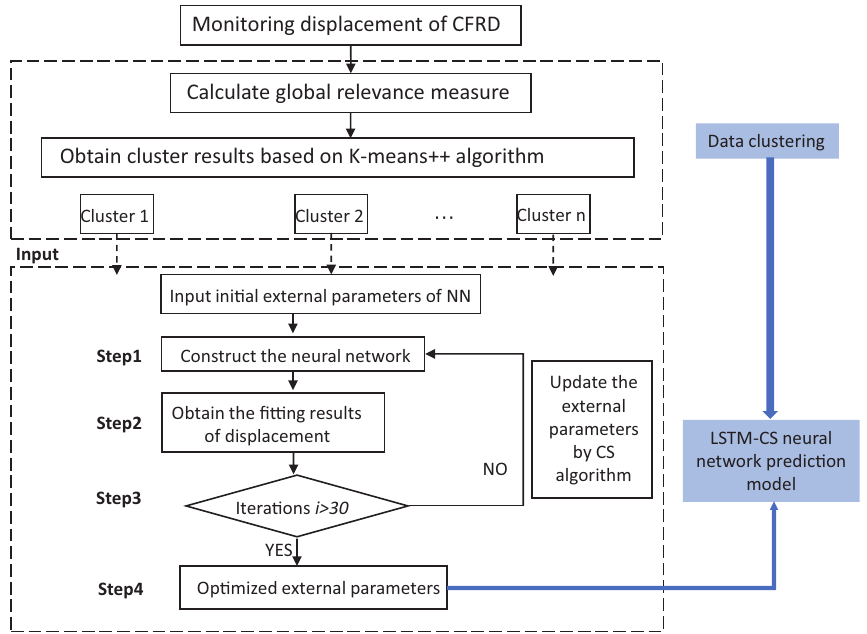
Figure 4. Flowchart of the proposed method for predicting the settlement of CFRD.